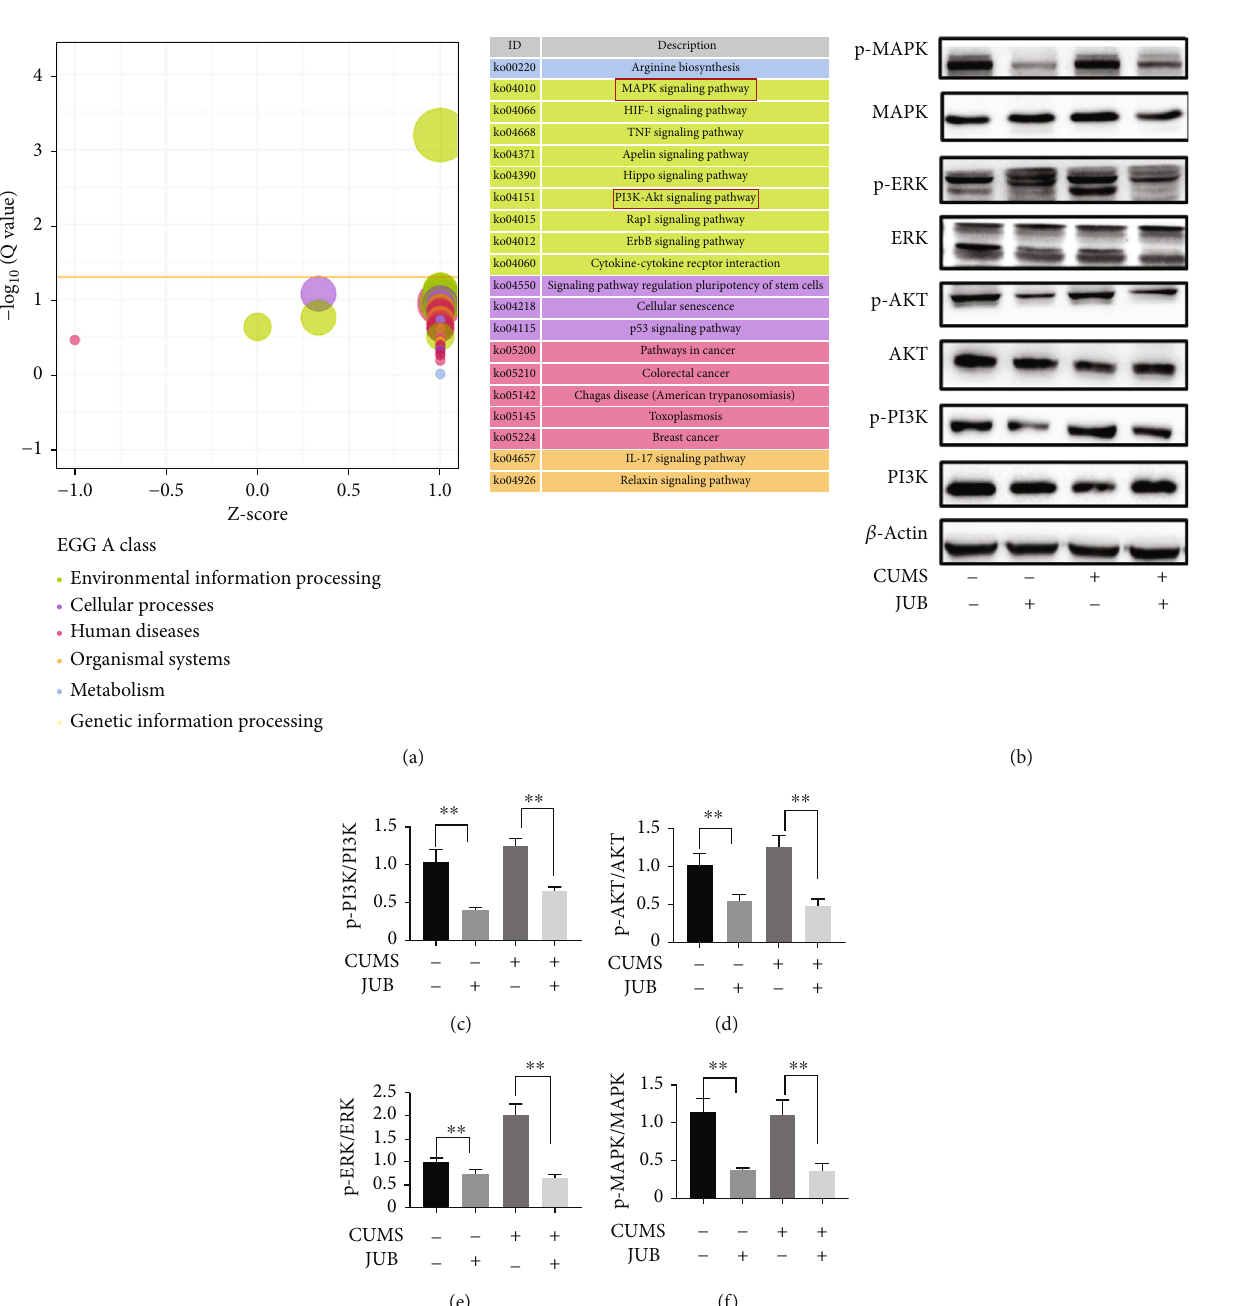
Figure 7: E ff ect of JUB and CUMS on apoptosis proteins in tumor tissues. (a) mRNA-seq of tumor in group B and F. (b) Protein expression bands of tumor tissues. (c – f) Statistical analysis of p-PI3K/PI3K, p-Akt/Akt and p-MAPK/MAPK, and p-ERK/ERK. Data were expressed as mean ± SD ( n = 8/ g roup ). ∗ P < 0 : 05and ∗∗ P < 0 : 01